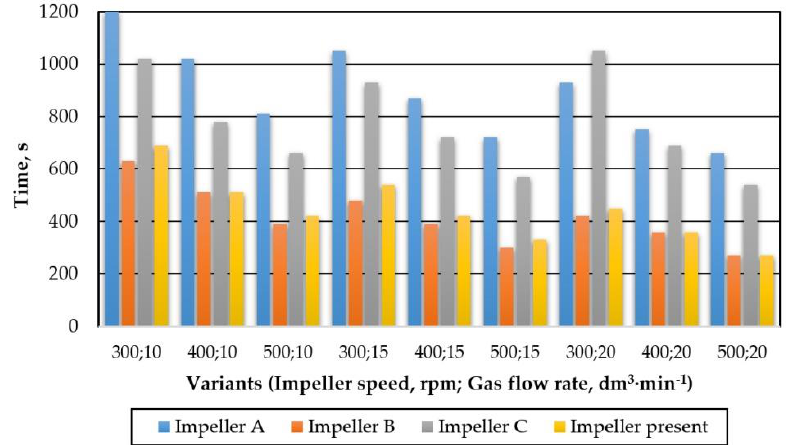
Figure 7. Summary of the refining times needed to remove 90% of dissolved oxygen for the tested variants for four different impellers.